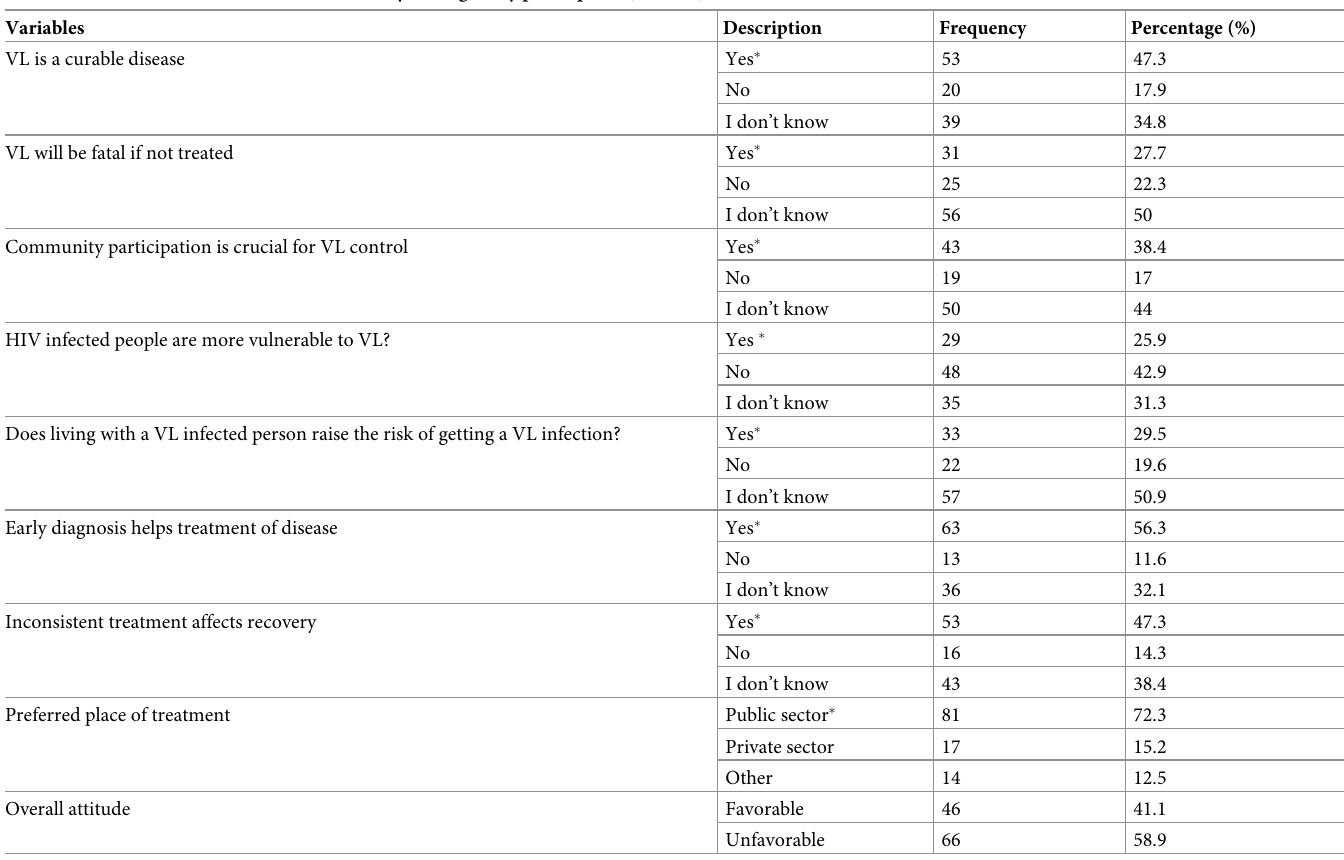
Table 4. Attitude towards VL and its treatability among study participants (N =